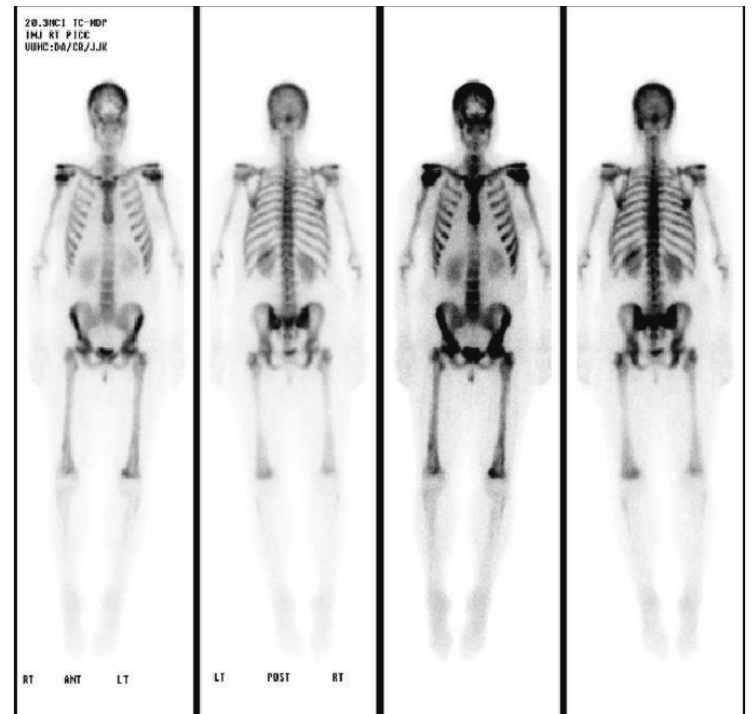
Figure 4: Diffuse metastatic involvement of the osseous skeleton consistent with known diagnosis of neuroblastoma with a large right pelvic mass. The two left most panels represent pre-MIBG treatment. The two right-most panels represent images obtained 25 days following therapeutic